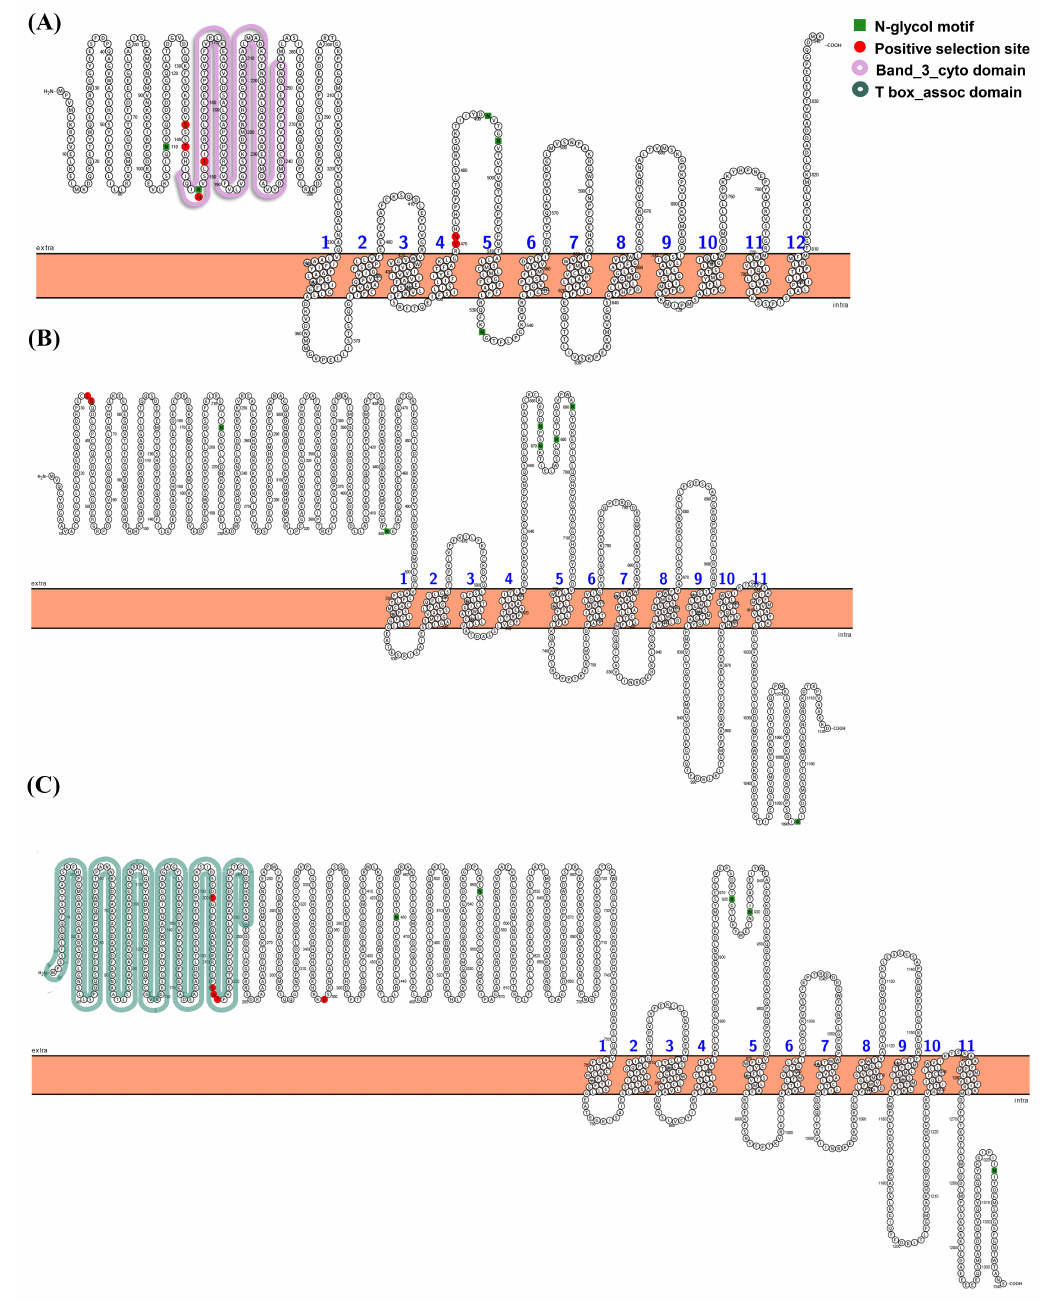
Figure 6. Distribution of positive selection sites of the slc4 genes of spotted sea bass predicted by the branch-site models. Positively selected sites ( p > 95%) in the predicted secondary structures of slc4a1b ( A ), slc4a8 ( B ), and slc4a10b ( C ) were labeled in red. The functional domains were marked with di ff erent colors.